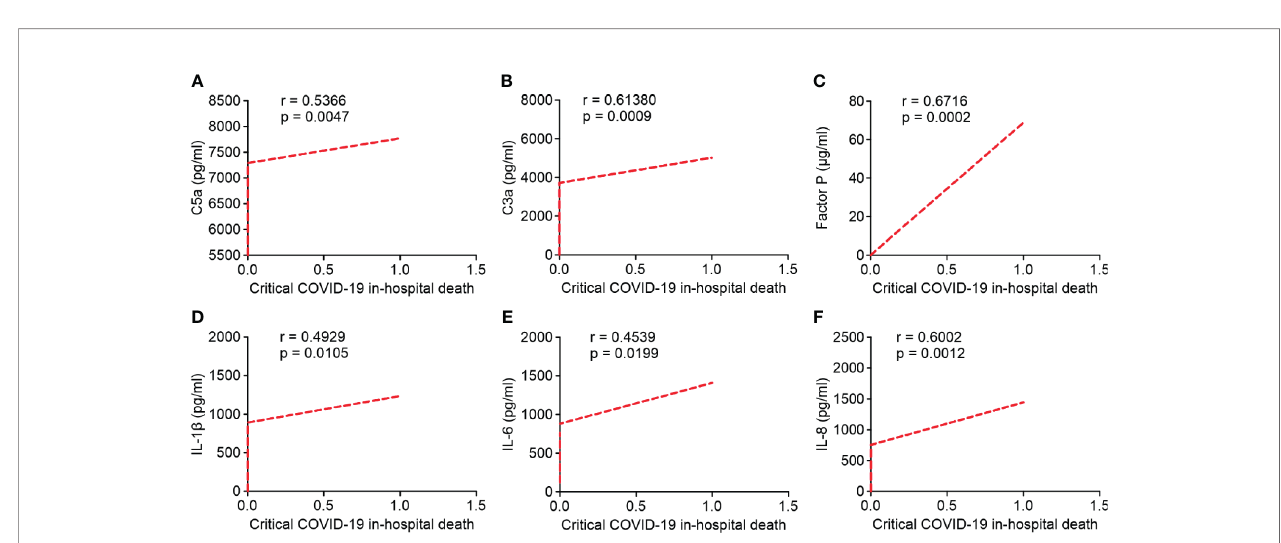
FIGURE 6 | Correlation between serum complement components and in fl ammatory cytokine/chemokine levels in critical COVID-19 patients who died in hospital. (A) complement fragment C5a ( P = 0.005); (B) complement fragment C3a ( P < 0.001); (C) factor P ( P < 0.001); (D) interleukin 1 b (IL-1 b ) ( P = 0.01); (E) interleukin 6 (IL-6) ( P = 0.02); (F) interleukin 8 (IL-8) ( P =